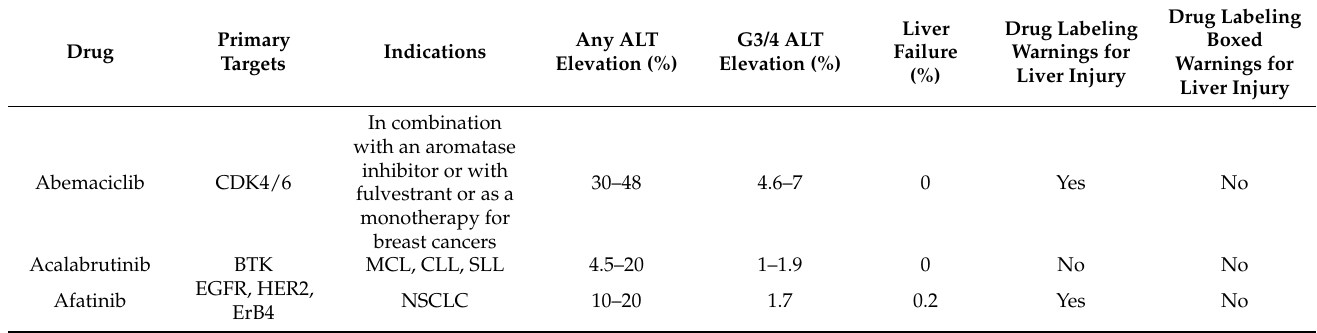
Table 1. Main factors involved in liver injury secondary to PKIs approved for